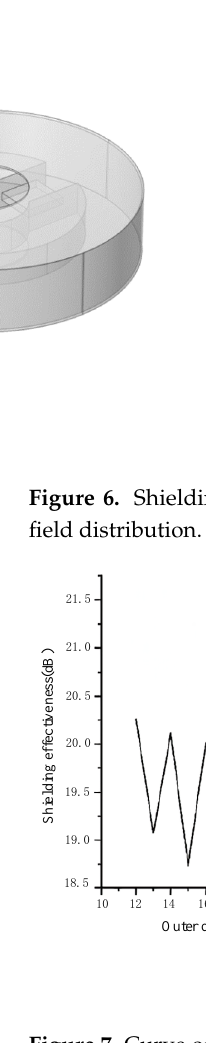
Figure 7. Curve of shielding effectiveness of the shielding enclosure varying with size: ( a ) variation in shielding shell outer diameter, and ( b ) variation in shielding shell height.